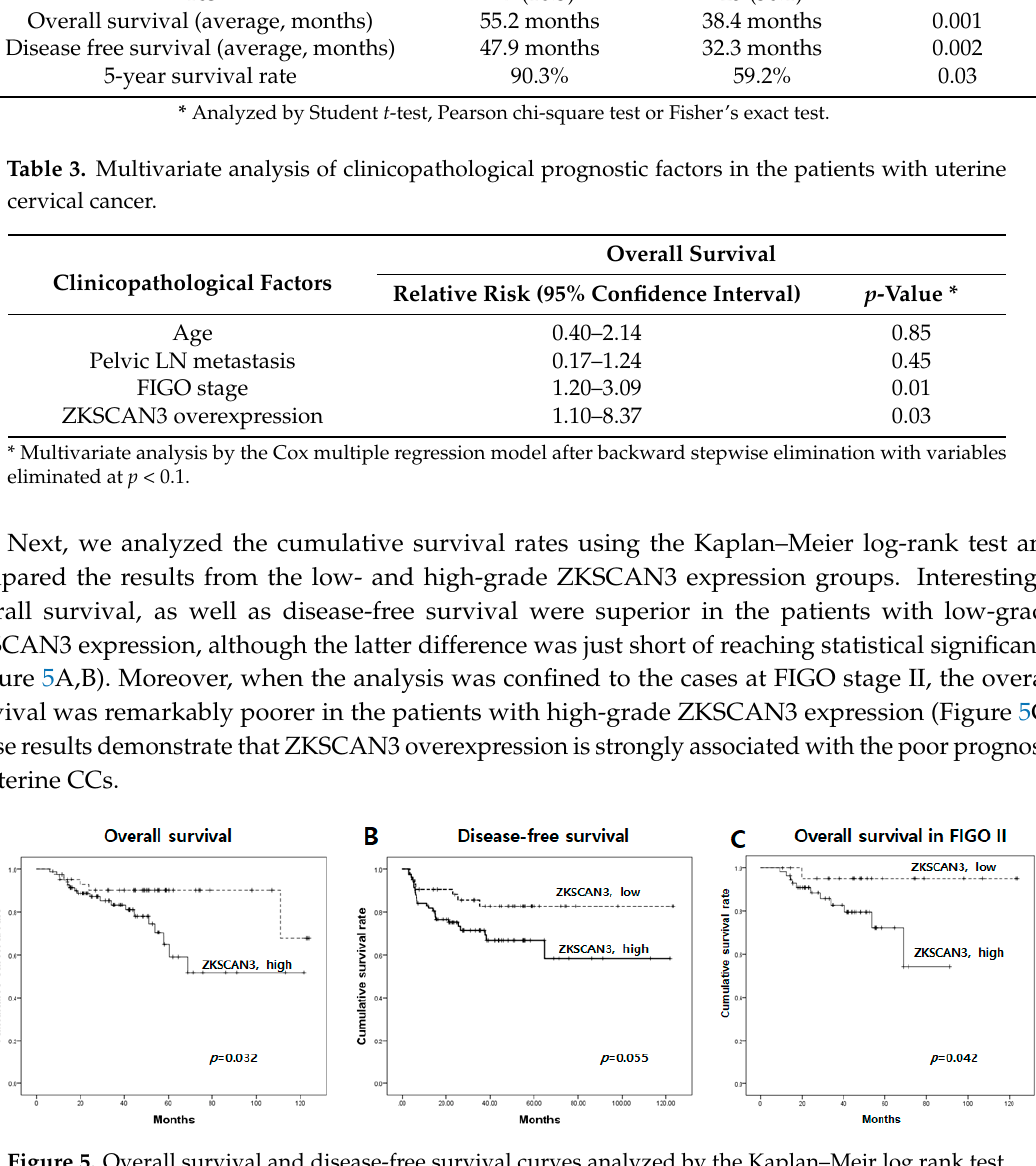
Figure 5. Overall survival and disease-free survival curves analyzed by the Kaplan–Meir log rank test, showing that high-grade of ZKSCAN3 overexpression is associated with a shorter survival time in patients with uterine cervical cancers. ( A ) Comparison of overall survival rate of patients with low- or high-grade ZKSCAN3 expression. ( B ) Comparison of disease-free survival rate of patients with low- or high-grade ZKSCAN3 expression. ( C ) Overall survival rate of the patients in FIGO stage II with low- or high-grade ZKSCAN3 expression.